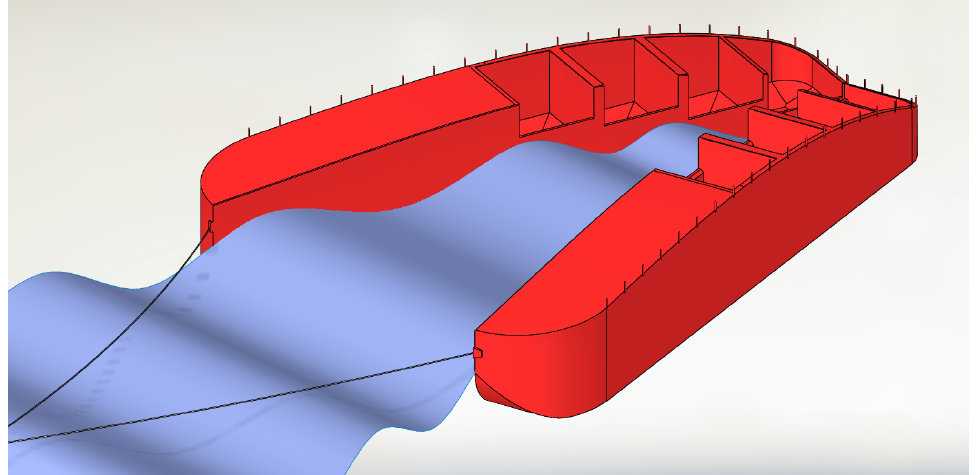
Figure 1. The WaveCat concept showing twin hulls containing on-board tanks converging at the rear of the